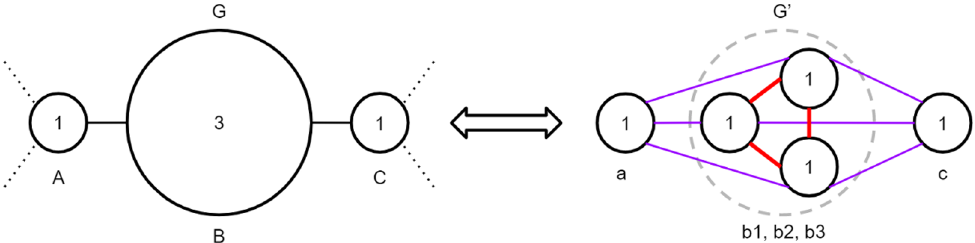
Figure 15. The principle of node splitting invariance means that a node-weighted graph G is equivalent to a refined graph G’ where all nodes have been split into a number of unweighted nodes proportional to the weight. Here node B is split into b1, b2 and b3. The nodes b1, b2 and b3 are assumed to have i) full internal connectivity (red links) and ii) identical external connectivity (purple